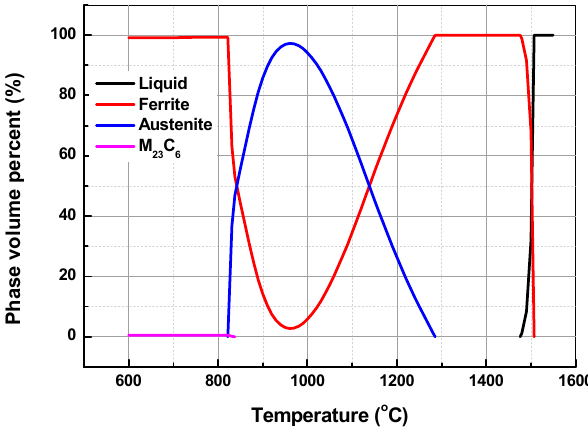
Figure 1. Thermodynamic equilibrium phase diagram of the material under study.